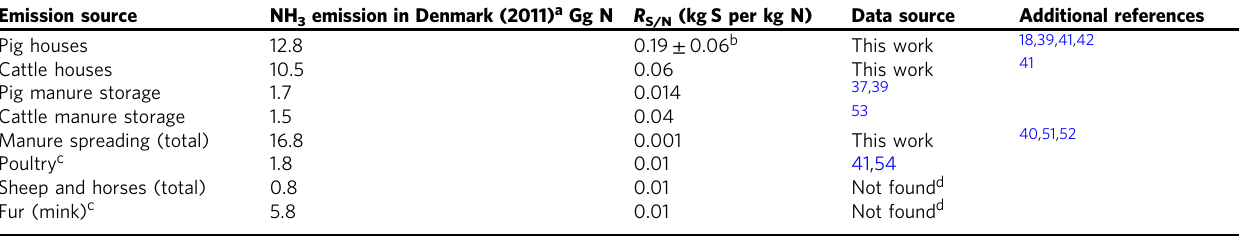
Table 3 Values of R S/N used for estimating sulfur emissions from agricultural sources Emission source